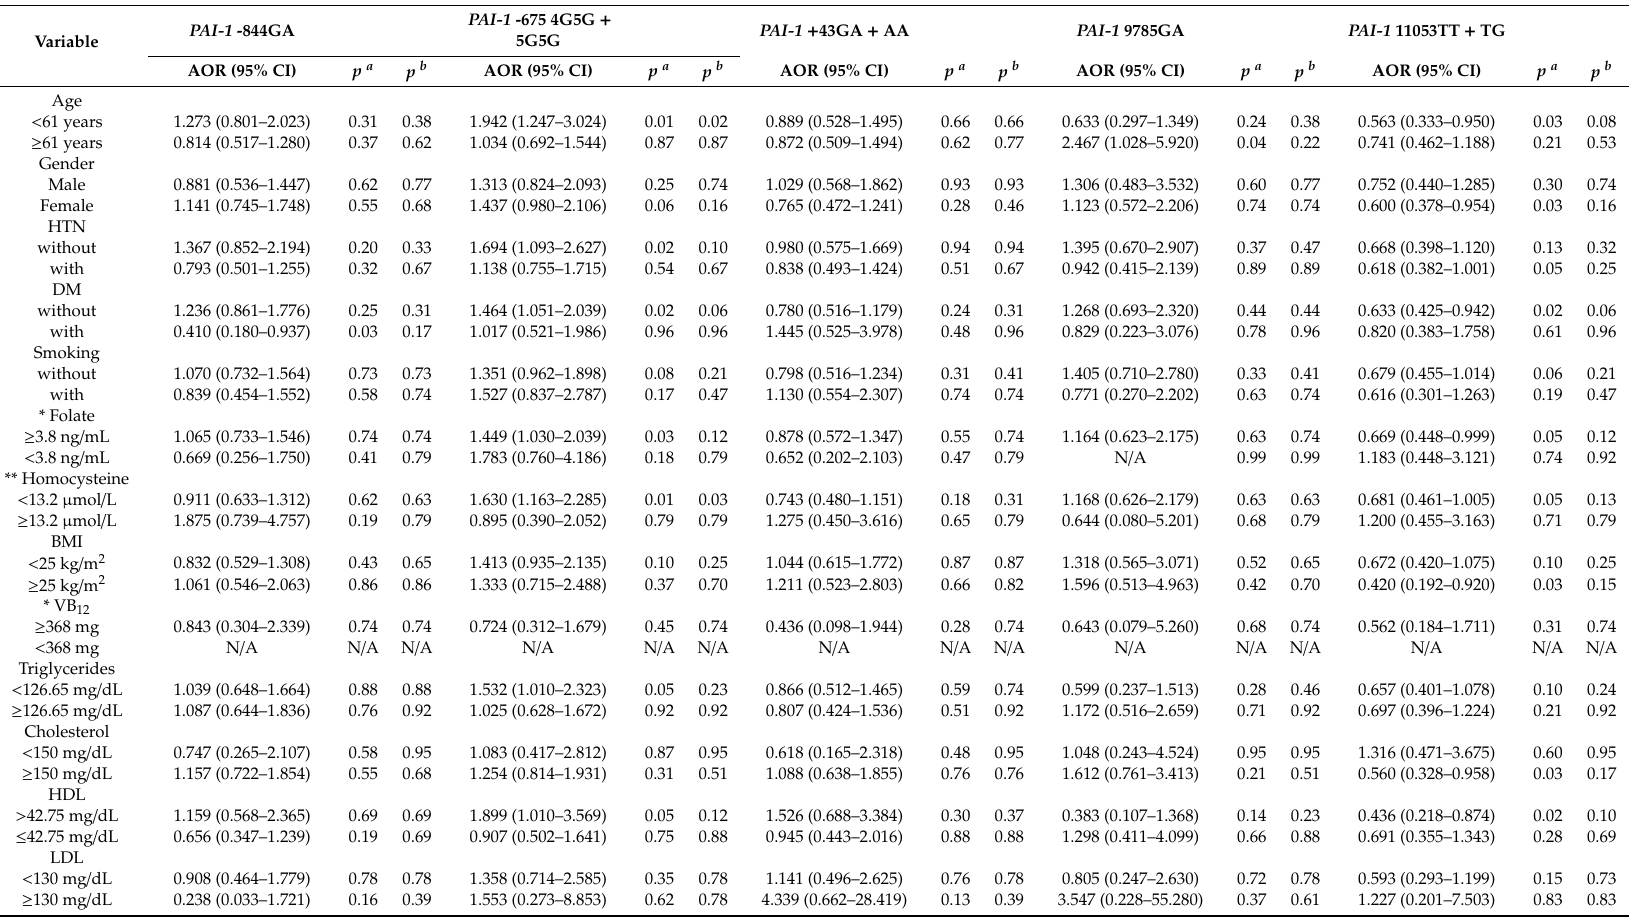
Table 3. Stratified e ff ects of PAI-1 gene polymorphisms on colorectal